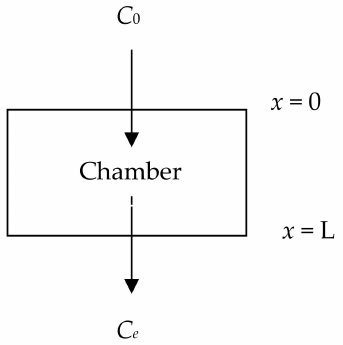
Figure A1. Sketch of mass balance approach for kinetic models of